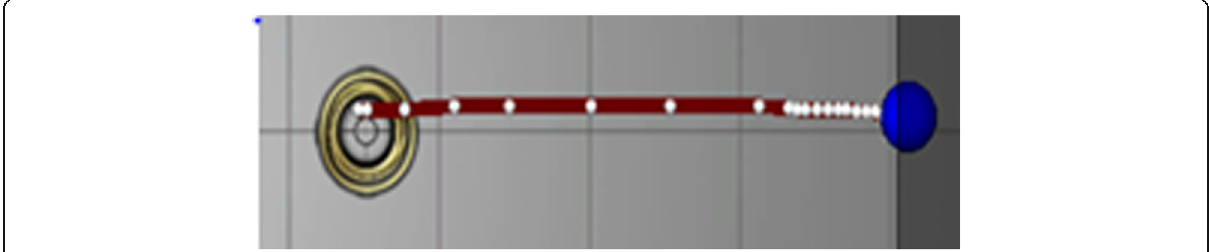
Fig. 6 Close-up of acceleration in a motion map dot trail . Notice how the white dots get closer together towards the end of the finger swipe connoting negative acceleration